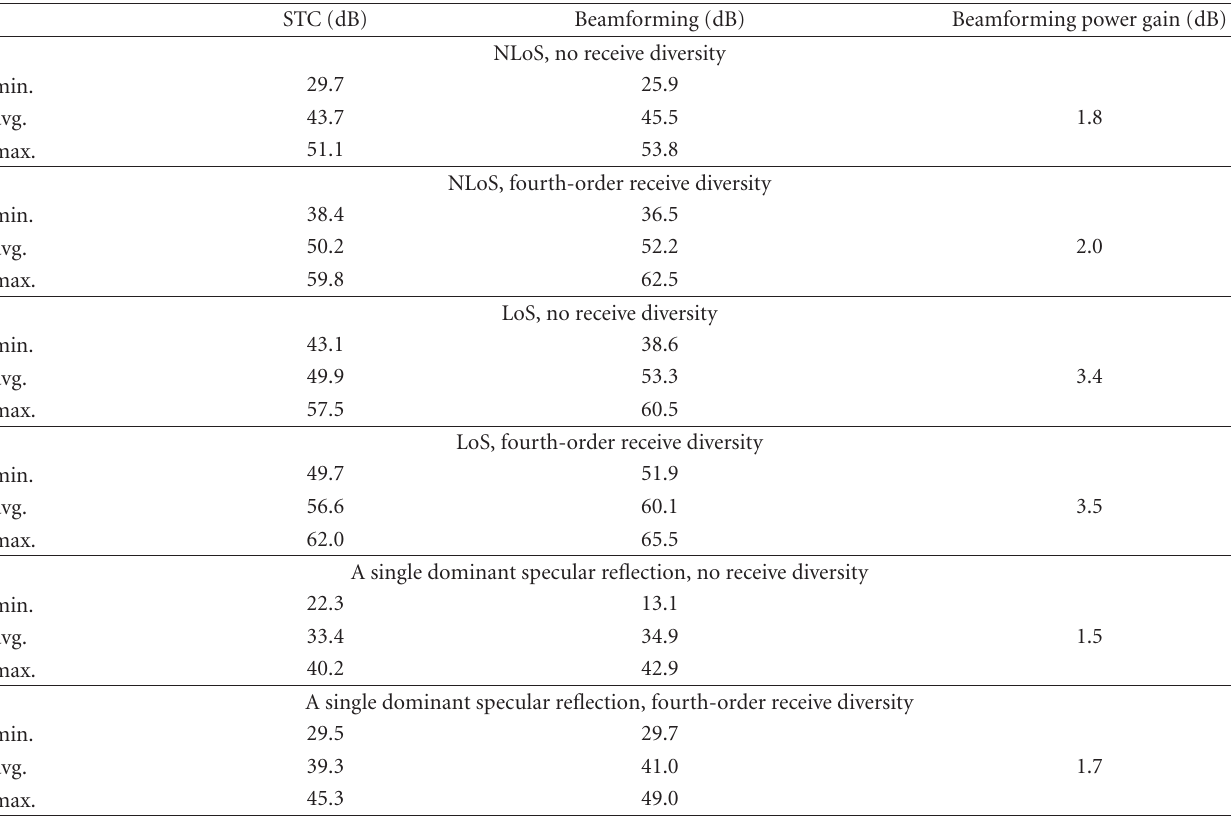
Table 3: E b /N 0 for STC and beamforming; beamforming power gain.